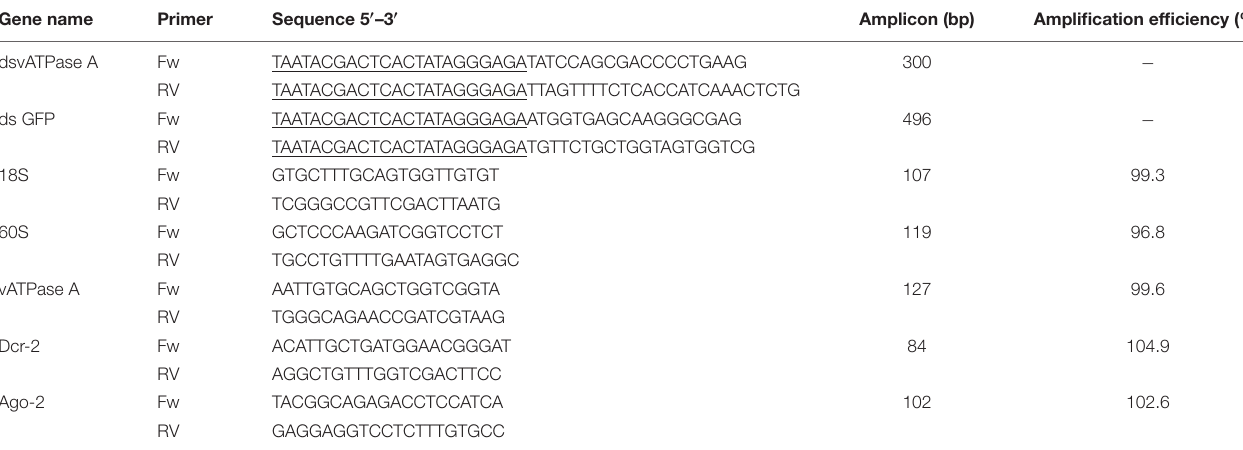
TABLE 4 | Primers used for dsRNA synthesis and